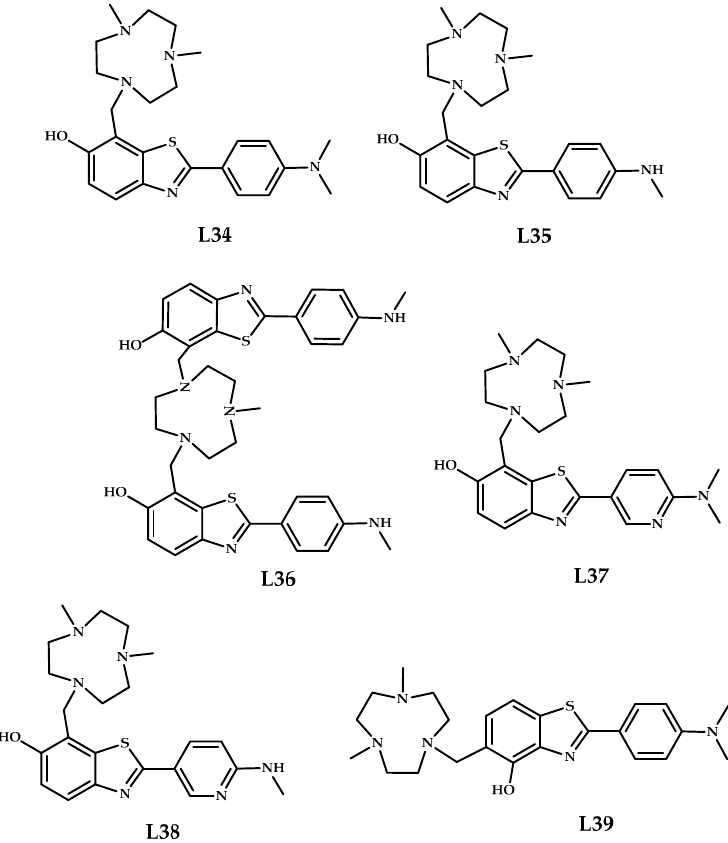
Figure 10. Pittsburg compound B derivatives, conjugated with metal-chelating 1,4-dimethyl-1,4,7- triazacyclononane L34 – 39 , designed for A β fibrils binding.